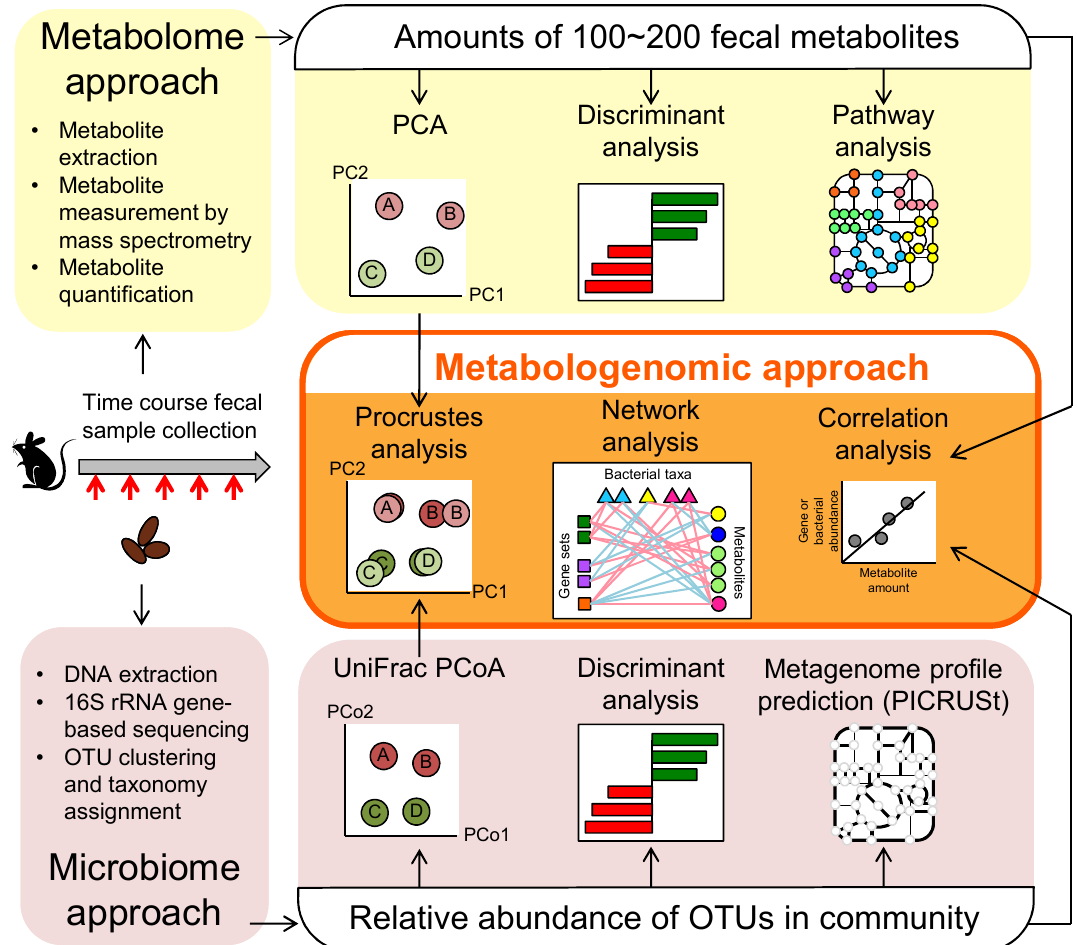
Figure 1. Overview of metabologenomic analysis workflow. Steps used for evaluation of metabolome profiles are summarized in the top row (yellow shading). This process starts with measurement of the amount of fecal metabolites to obtain profiles for the 100–200 metabolites. These metabolome profiles then are compared using Principal Component Analysis (PCA), discriminant analysis, and pathway analysis. Steps used for evaluation of microbiome profiles are summarized in the bottom row (pink shading). This process starts with the sequencing of the community’s 16S rRNA-encoding genes to clarify the relative abundance of operational taxonomic units (OTUs). Microbial memberships and structures are compared using UniFrac principal coordinate analysis (PCoA) and discriminant analysis. Additionally, Phylogenetic Investigation of Communities by Reconstruction of Unobserved States (PICRUSt) is used to predict metagenomic profiles. Steps for metabologenomic analysis are summarized in the central part of the figure (middle row; orange shading). The PCoA and/or PCA plots are used for Procrustes analyses. The relative abundances of microbial taxonomy and/or metagenome profiles and amounts of metabolites then are used for correlation analysis and network